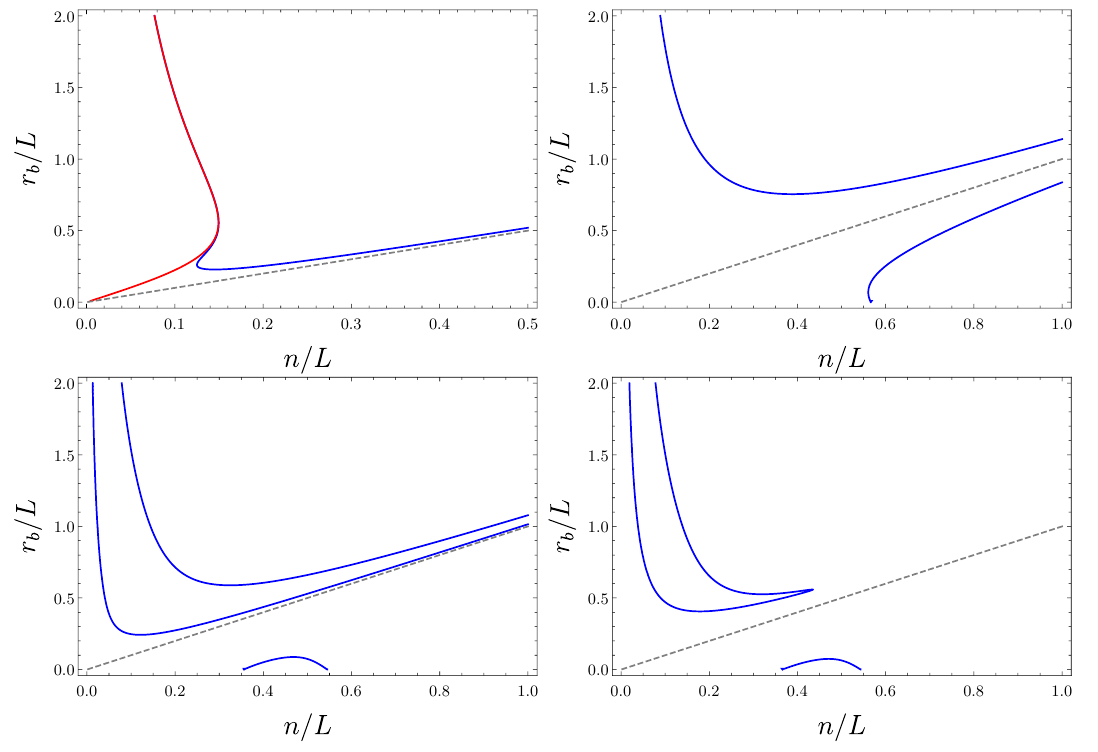
Figure 16 . Roots of the equation (A.17) for several values of the parameters. Only the roots above the reference dashed line r b = n admit the construction of bolt solutions. Upper left: behaviour in region A when the parameters are very small ( (cid:22) = (cid:24) = 10 (cid:0) 5 in this case); there is a range of n with three di(cid:11)erent bolt solutions. Upper right: (cid:22) = 0 : 05, (cid:24) = 0 : 05; this represents the typical case for region A . Lower left: region B 1 ( (cid:22) = 0 : 05, (cid:24) = (cid:0) 0 : 002); there are two roots for every value of n . Lower right: region B 2 ( (cid:22) = 0 : 05, (cid:24) = (cid:0) 0 : 0052); there are two roots if n is smaller than certain value; both diverge as n !